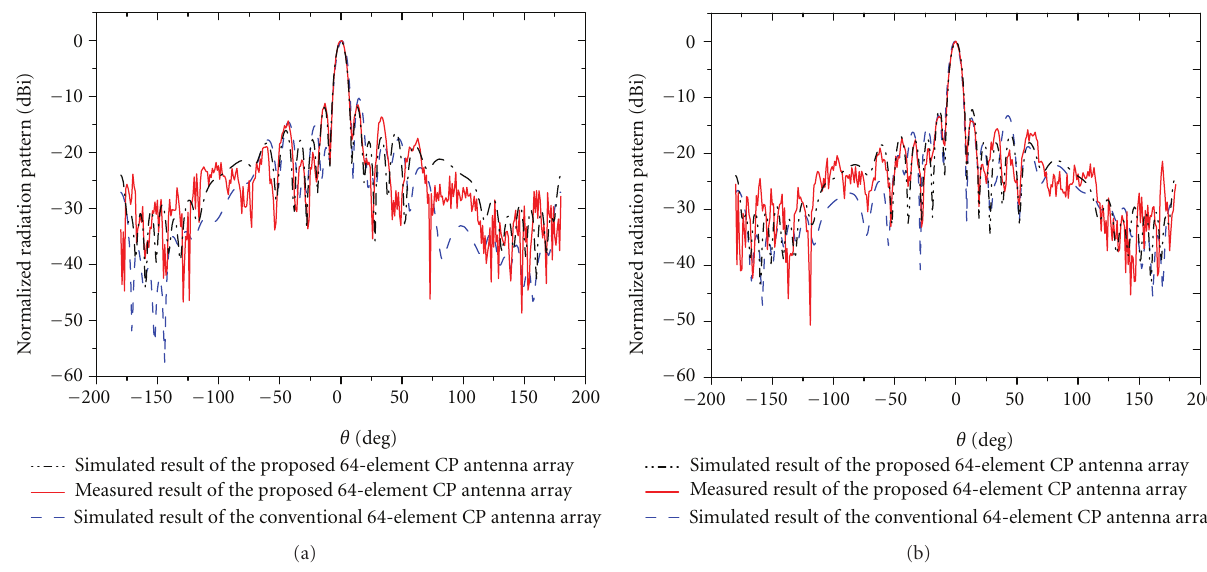
Figure 14: Measured and simulated radiation patterns of the 64-element CP antenna arrays at 29GHz: (a) ϕ = 0 ◦ , (b) ϕ = 90 ◦ .